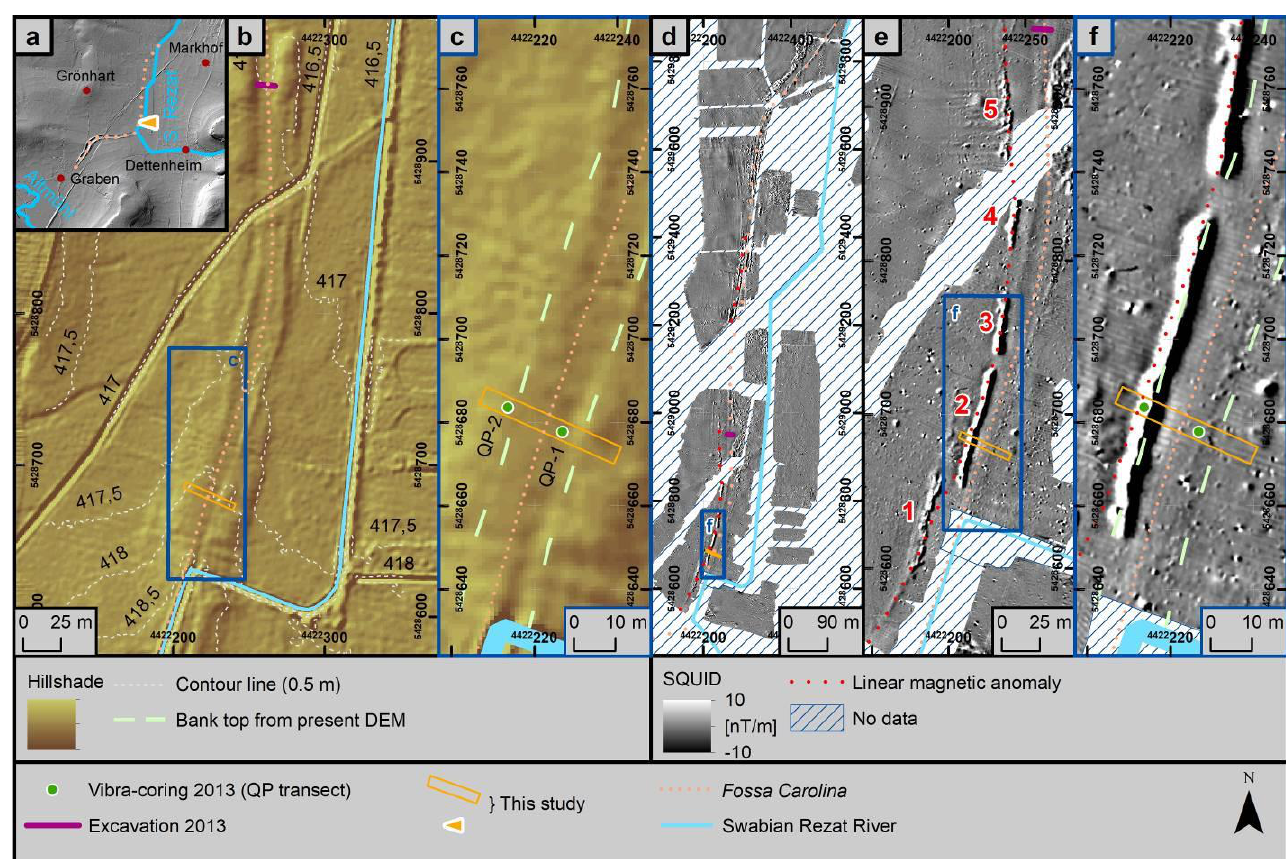
Figure 2. SQUID and digital elevation model (DEM) analyses in the northern section and north-eastern section ( a ). The DEM provides indications of the location of the buried banks in the form of elevation that is slightly visible ( b , c ). The magnetic SQUID survey revealed an extensive, intensive magnetic anomaly ( d , e , f ) [42] parallel to the canal, which can be divided into segments (1-5) by its interruptions ( e ). ( b - f ) Locations of the preliminary vibracoring transect [39] and the archaeological excavation [4] are marked. (Database: LiDAR data are provided by the Bavarian Land Surveying Office).